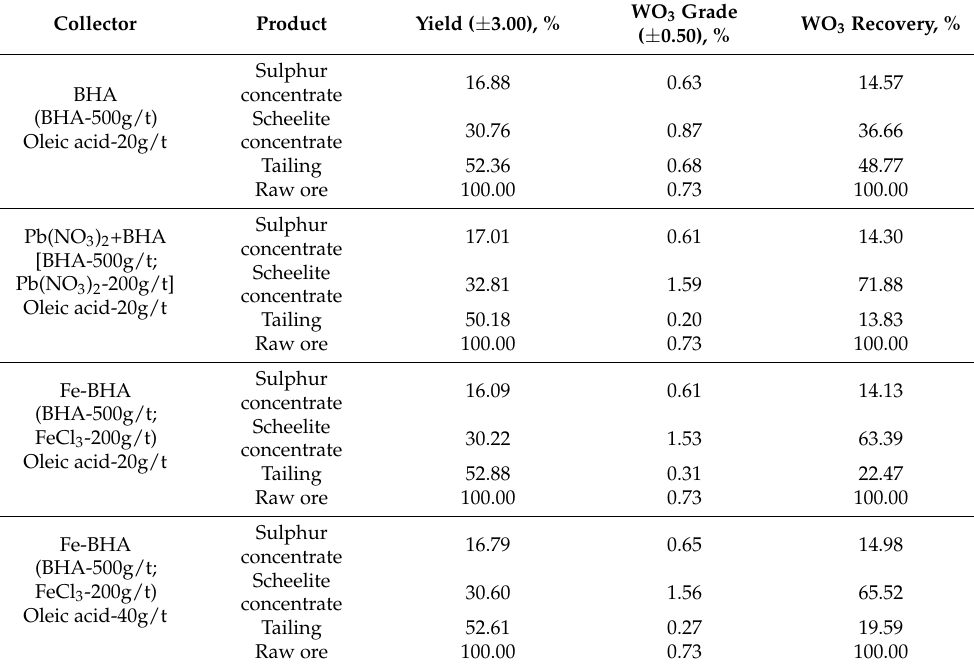
Table 2. Results of the roughing tests of Xianglushan scheelite ore as a function of the collector